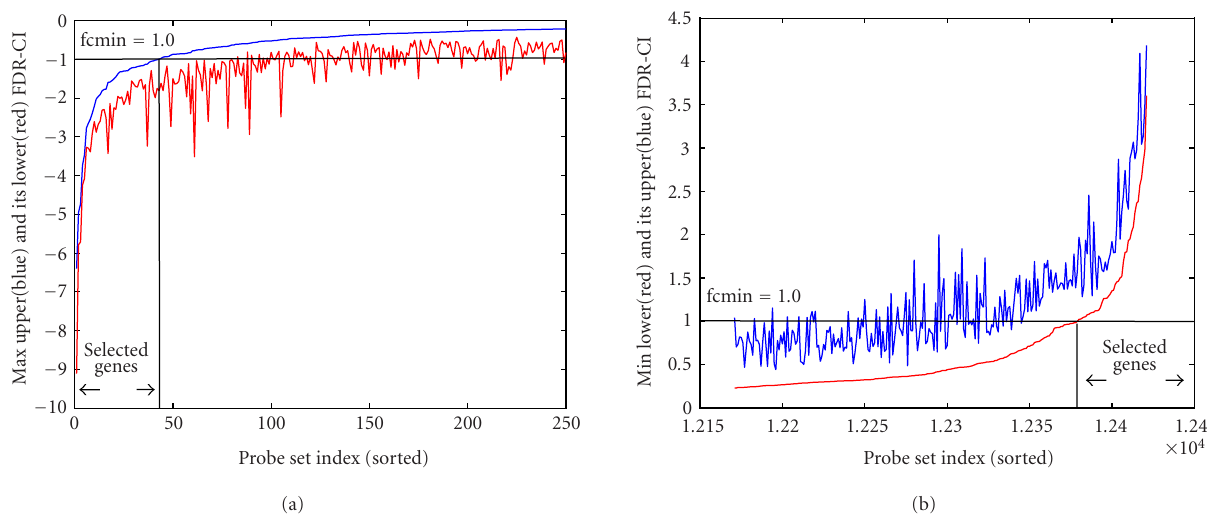
Figure 3: Segments of upper and lower curves specifying the 80% FDR-CI on the foldchanges { µ t ( g ) − η t ( g ) } t = 1,2,3 for the knockout versus wild-type study. Upper and lower curves in each figure sweep out FDR-CI upper and lower boundaries on foldchange for all genes (indexed by probe set number). In (a) the curves sweep out the sequence of FDR-CIs indexed in an increasing order of the (maximum) lower CI boundary and in (b) the ordering is in an increasing order of the (minimum) upper CI boundary. Only those genes whose three FDR-CIs do not intersect [ − fcmin,fcmin] are selected by the second stage of screening. When the MAD foldchange criterion is fcmin = 2 . 0 (1 . 0 in log base 2), these genes are obtained by thresholding the curves as indicated.